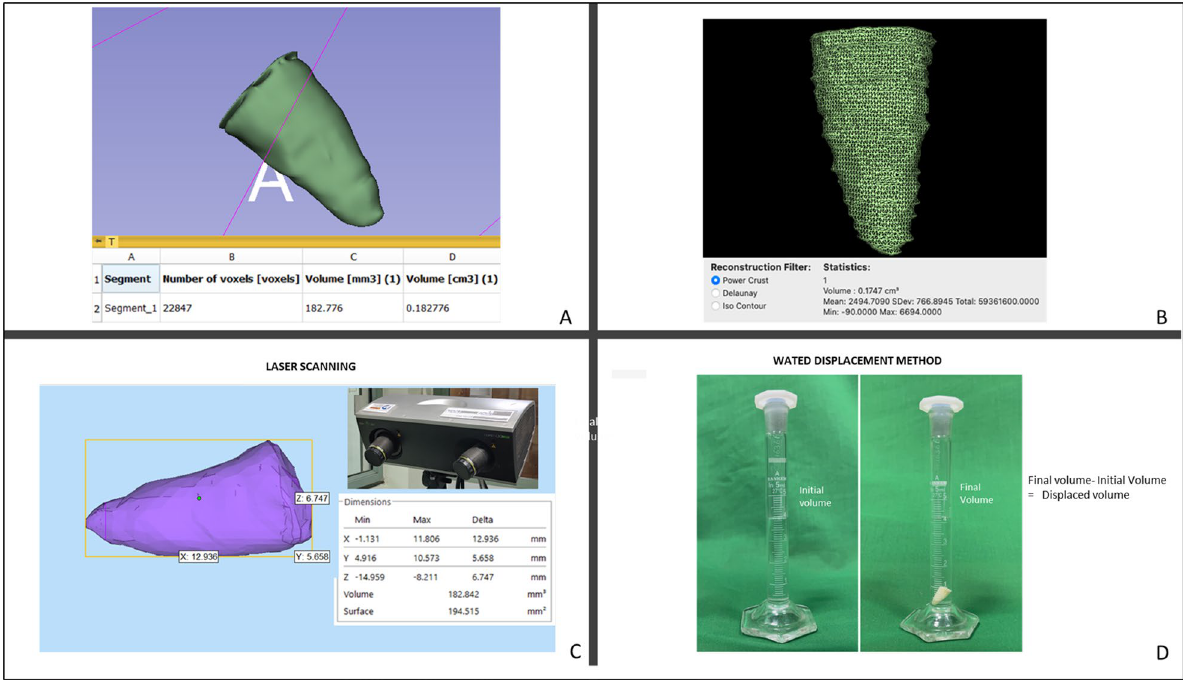
Figure 1. In vitro Validation. Tooth root volume assessment by CBCT segmentation with (A) OsiriX MD and (B) 3D Slicer software’s. (C) Illustrates volumetric analyses of the tooth root in Materialise MiniMagics software after scanning with Steinbichler COMET L3D laser equipment. (D) Illustrates volume estimation of the tooth root by water displacement method. OsiriX